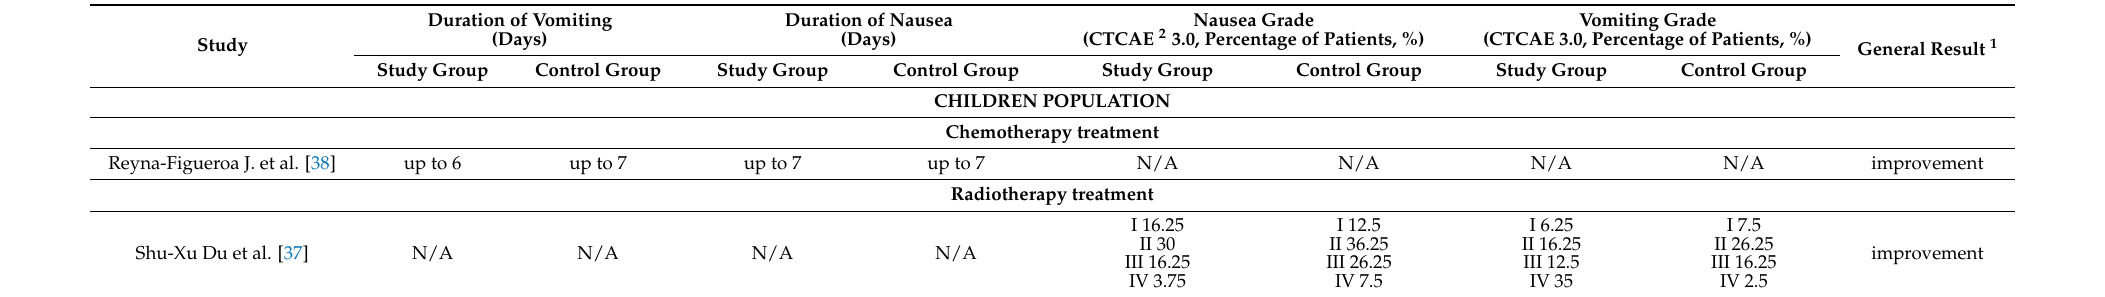
Table 5. The occurrence of nausea and vomiting during the probiotic